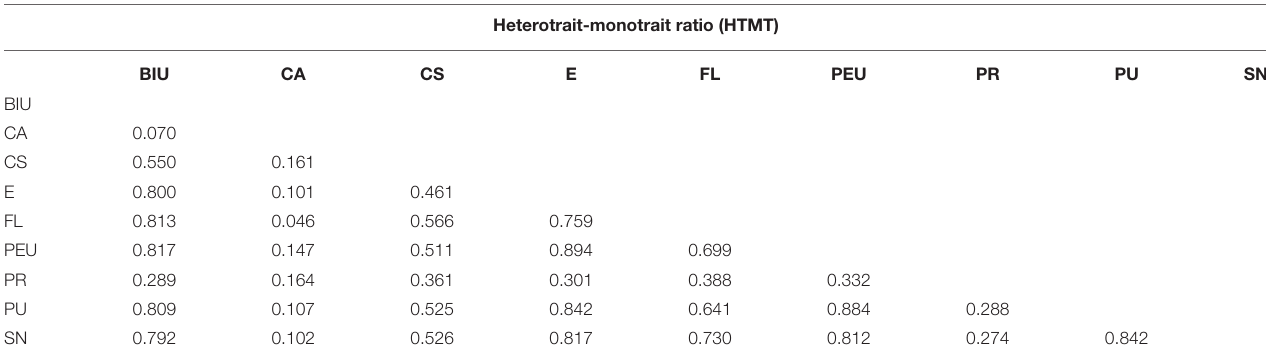
TABLE 5 | Discriminant validity [Heterotrait-monotrait ratio